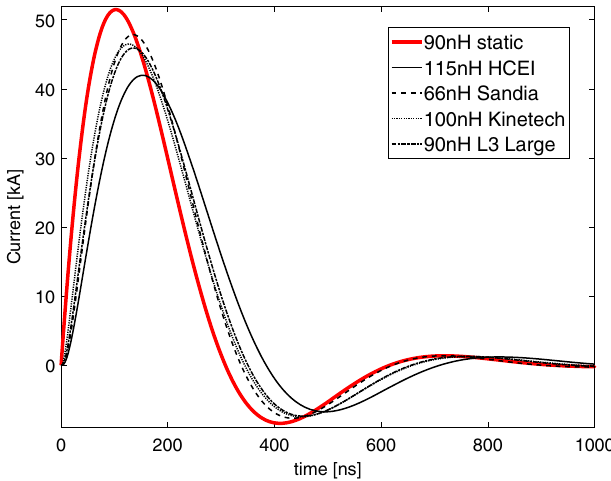
FIG. 5. Simulated output currents into matched load conditions for a standard brick assuming four different switch